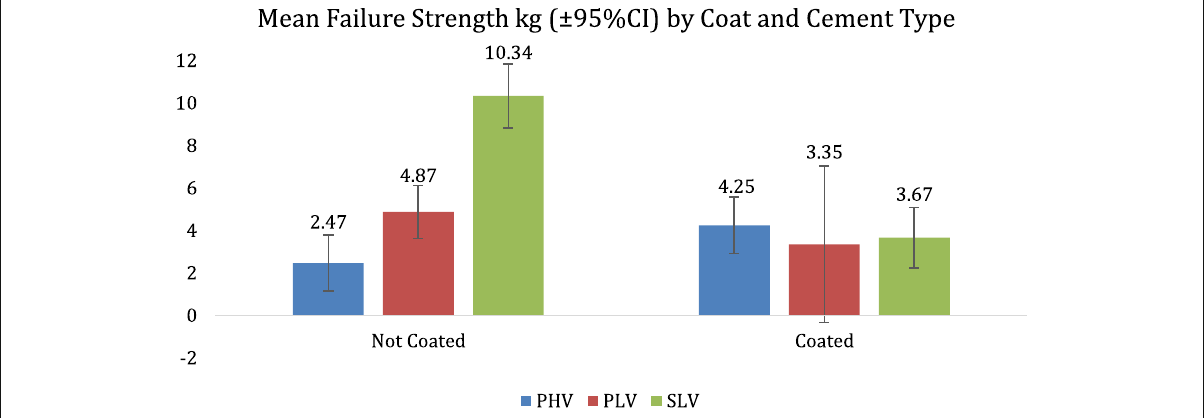
Fig. 3 Graph showing the variation in pull-off strength based on combinations of cement type and coating